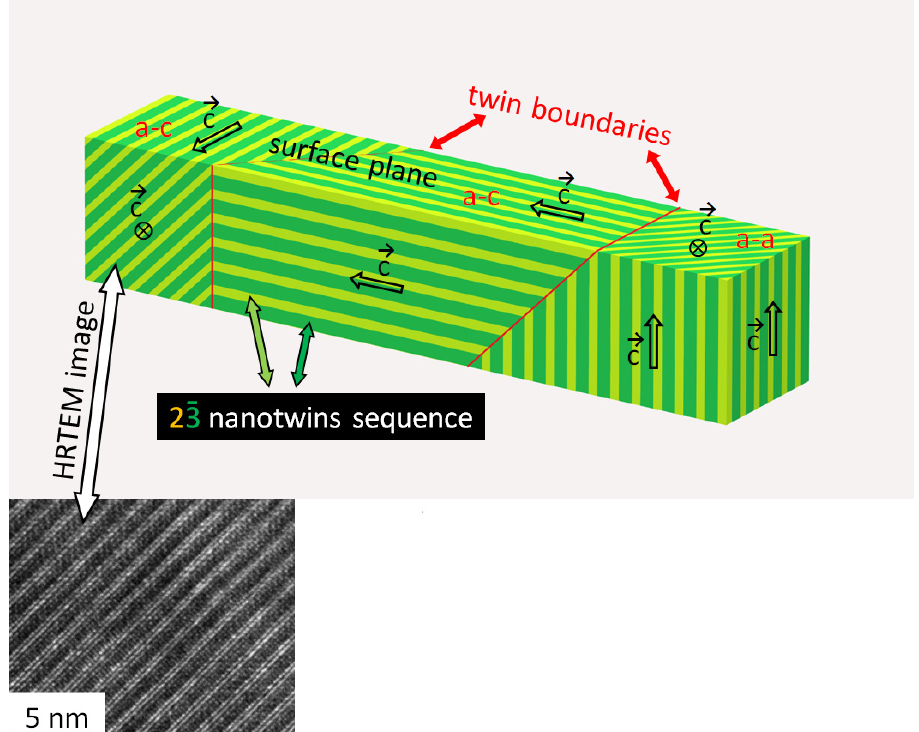
Figure 2. Schematic depiction of (32) nanotwinning in martensite; two a-c variants and one a-a variant are marked. Other variants can be obtained by rotation. High resolution transmission electron microscopy (HRTEM) cross-section image shows arrangement of the